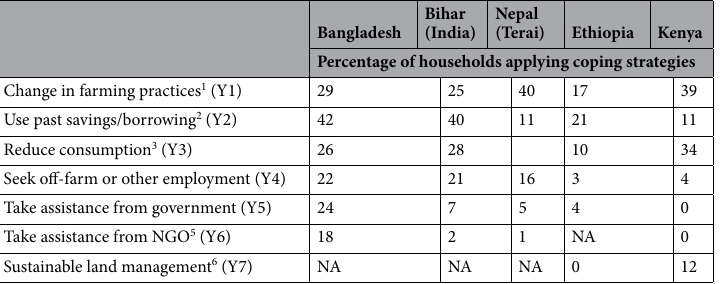
Table 1. Major climate risks and coping strategies applied by farm households in the study area. NA and − refer to not applicable and no data, respectively. Multiple responses are possible. 1. Change in farming practices include replanting, use of chemical fertilizer, use of pesticide and herbicide, buy livestock replacement, and diversify crops, plots, and livestock. 2. Use past savings/borrowings also includes selling assets (i.e., livestock, land, and jewellery). We also included ‘buying food from the market’ within this as the farmer needs to either use past savings or the borrowed money to buy the food or buy food on loan. 3. Reduce consumption includes eating less (reducing meal quantity/quality) and spending less on non-food items. 4. Take additional jobs includes both in the agricultural and non-agricultural sector. 5. Includes help from self-help groups, local and other non-governmental organizations. 6. Sustainable land management includes soil and stone bunds, tree planting, used soil and water conservation, and using a